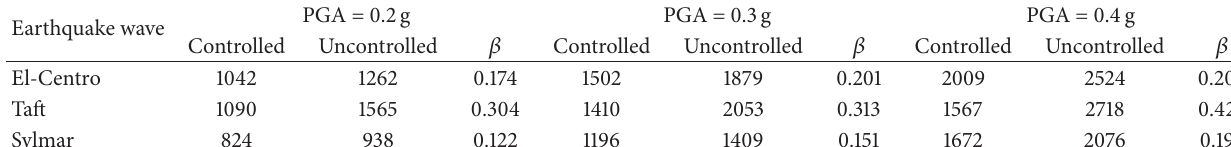
Table 3: Control effect of peak base shear in 𝑌 direction (units in kN).